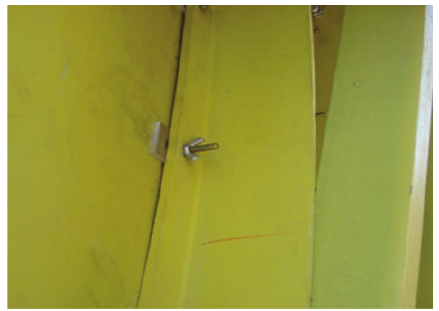
Figure 5: Partial view of imposing shim on the antenna